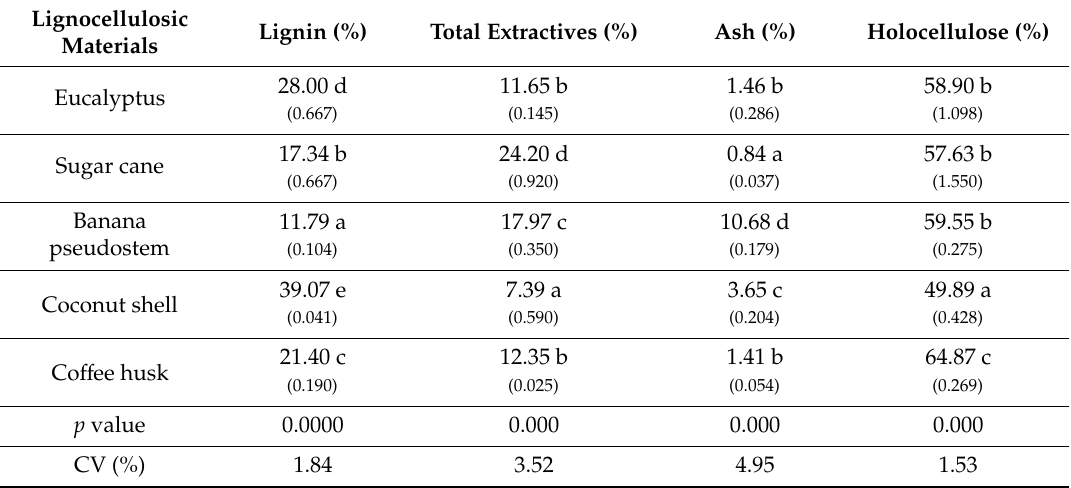
Figure 1. FreeViz optimization of the chemical composition of the lignocellulosic material residues. Table 1. Averages and standard deviations of the chemical compositions of the lignocellulosic material